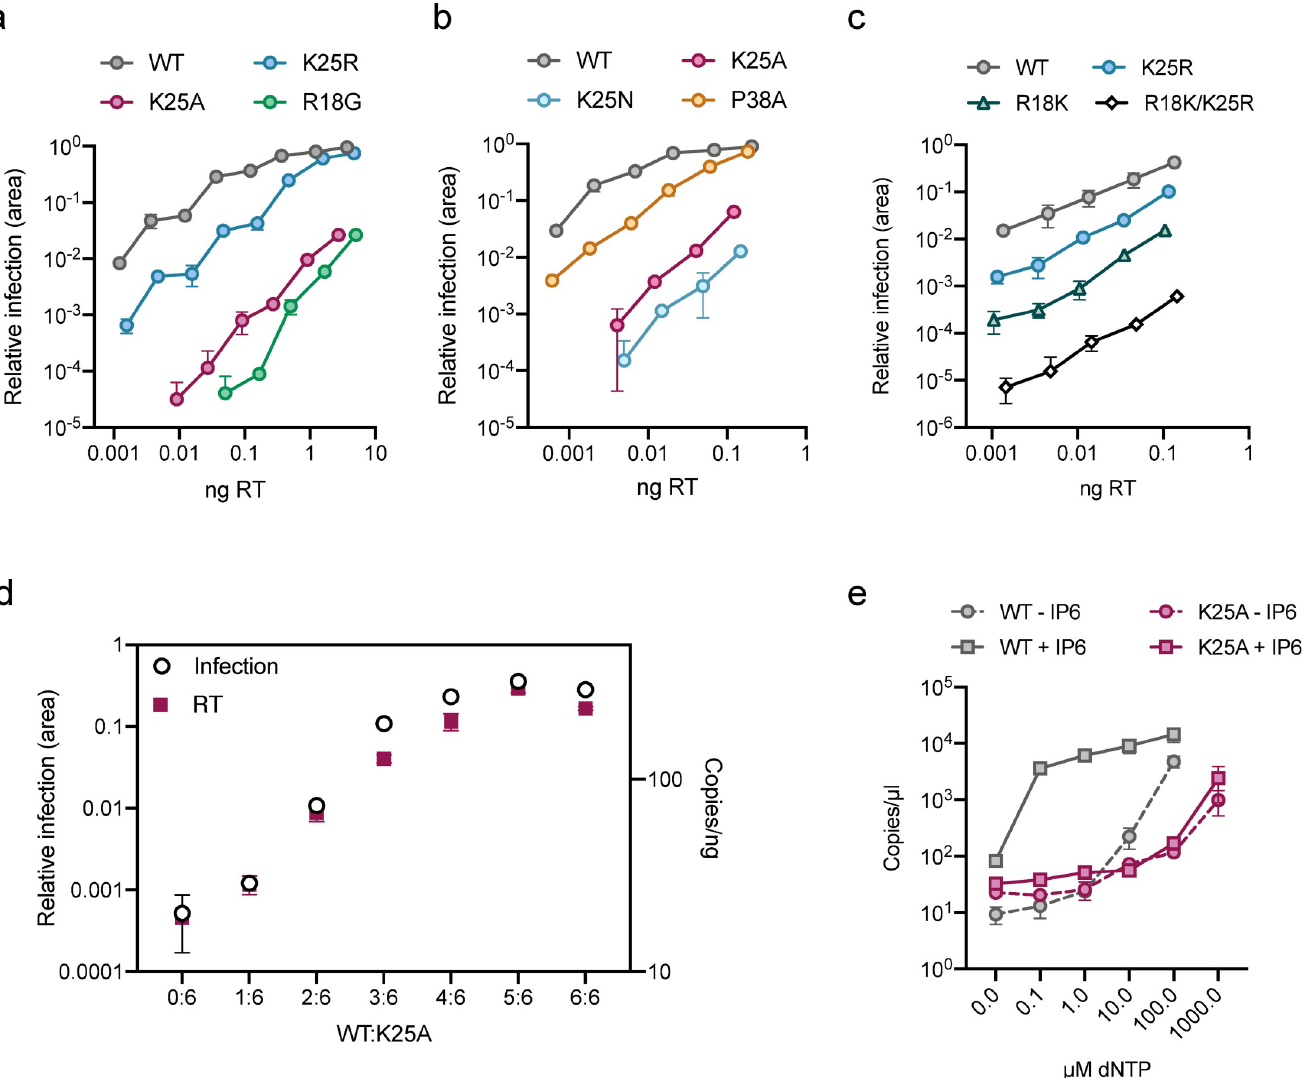
Fig 2. K25 is essential for reverse transcription and infection. (a&b&c) Infectivity of WT HIV and selected mutants. Infectivity is measured using an IncuCyte and determined as the proportion of cell area that is GFP +ve at a given viral dose (in ng RT). (d) Matching infectivity (GFP +ve cell area) and reverse transcription (strong-stop, RU5, at 4 hours post-infection) of chimeric viruses produced with an increasing ratio of WT:K25A Gag. (e) ERT assay measuring the synthesis of strong- stop DNA in the presence of DNase and at increasing concentrations of dNTPs. WT and K25A cores with and without IP6 (50 μ M). Data is average of three